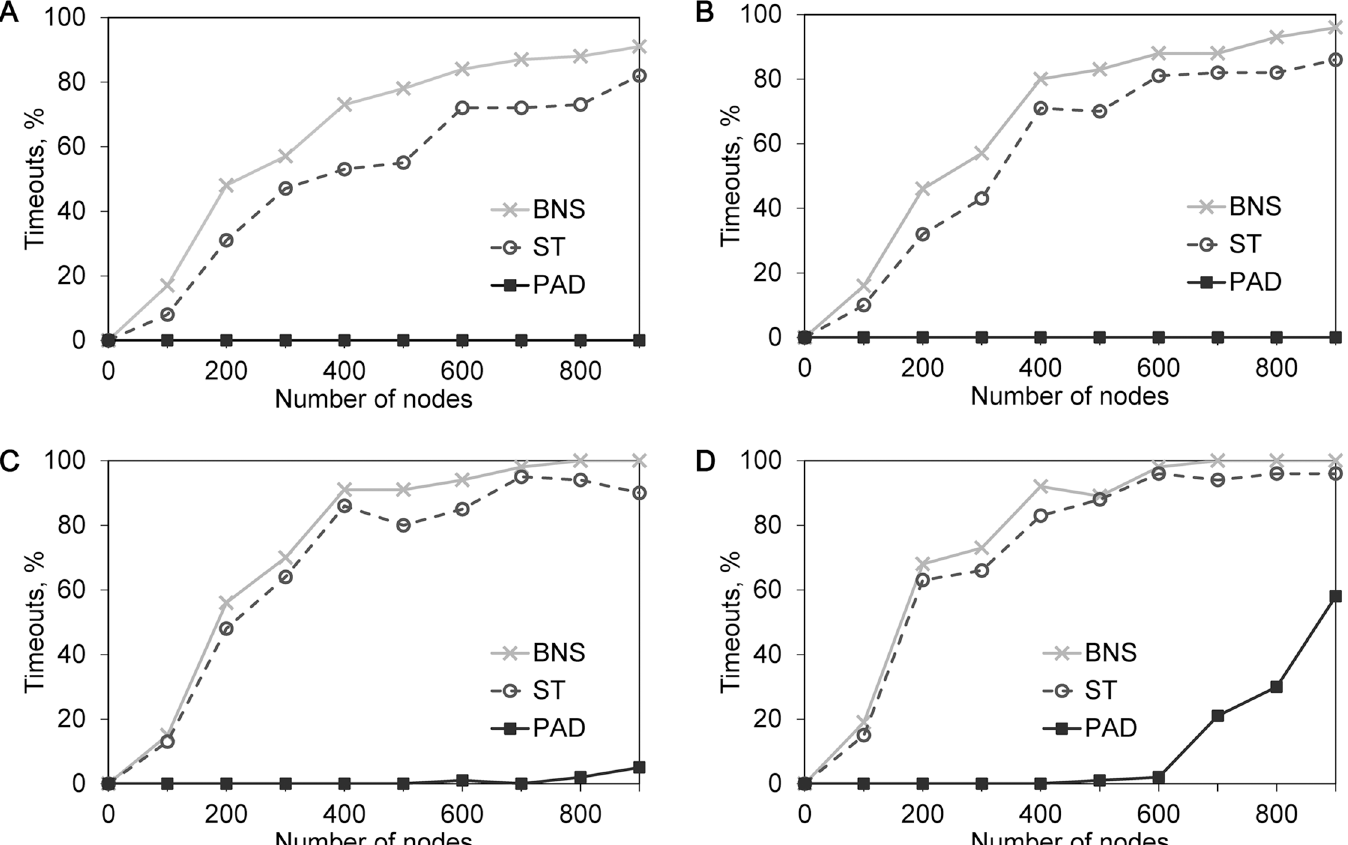
Fig 5. Scalability comparisions of algorithms. The simulation results for 3,600 randomly generated Boolean networks (BN) with maximum indegree K . Each dot is the percentage of timeouts computed for 100 networks. A: Timeout percentage of algorithms for BNs with K = 2. B: Timeout percentage of algorithms for BNs with K = 3. C: Timeout percentage of algorithms for BNs with K = 4. D: Timeout percentage of algorithms for BNs with K = 5.